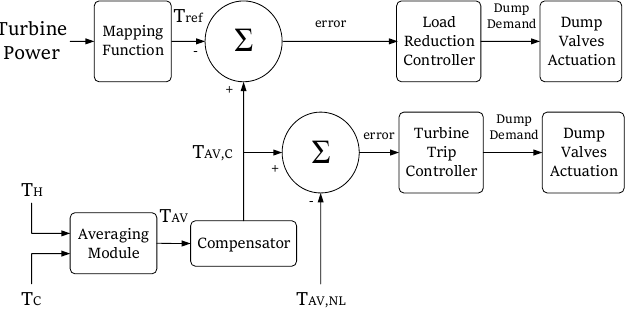
Fig. 2. Reactor coolant temperature mode of steam dump system Fig. 3. General structure of linear parameter varying system